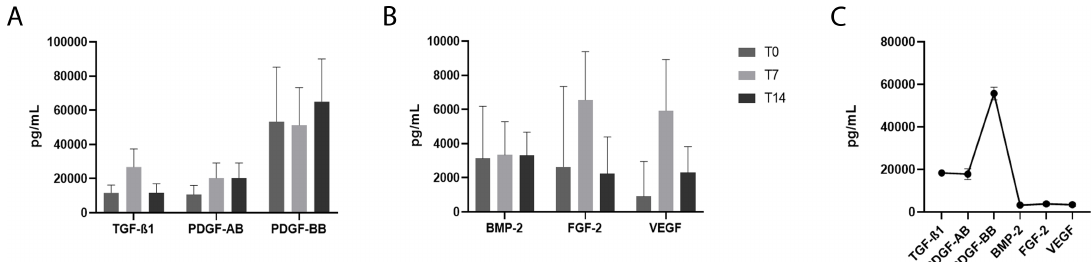
Figure 3. Growth factors’ release by liquid fibrinogen. The release of growth factors TGF- β , PDGF-AB, and PDGF-BB in ( A ), BMP-2, FGF-2, and VEGF in ( B ), was measured by ELISA at the moment of sample collection (T0), 7 days after collection (T7), and 14 days after collection (T14). The cumulative concentration of each factor, considering the 10 samples, calculated at T14 is reported in ( C ). TGF- β 1, transforming growth factor beta 1; PDGF-AB, platelet-derived growth factor-AB; PDGF-BB, platelet-derived growth factor-BB; BMP-2, bone morphogenetic protein 2; FGF-2, fibroblast growth factor 2; VEGF, vascular endothelial growth factor.